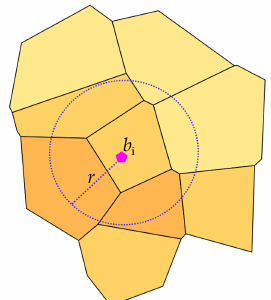
Figure 1. The HazardArea i around building b i (whose footprint is denoted as a fuchsia pentagon). A more intense color of the zone corresponds to a greater value of its Sz k .